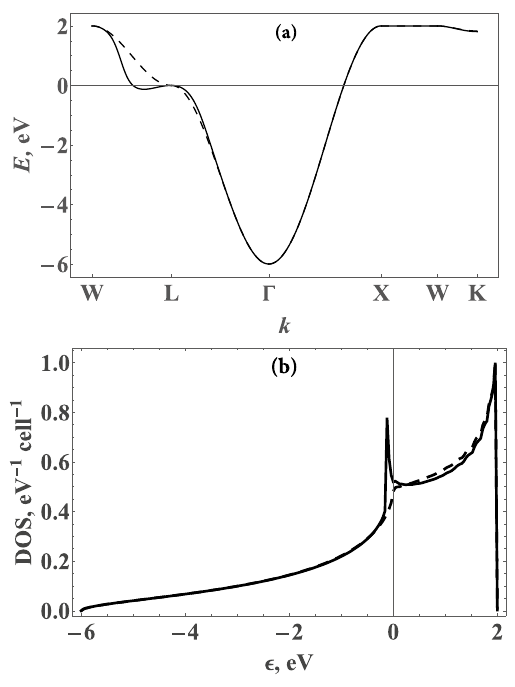
Fig. 3 Dispersion along the symmetry directions of BZ ( a ) and DOS ( b ) of the model conduction band, used in numerical calculations (thick lines). The dashed lines in the figure show the dispersion and DOS, respectively, of the simple band in the tight-binding approxi- mation, used in construction of the model